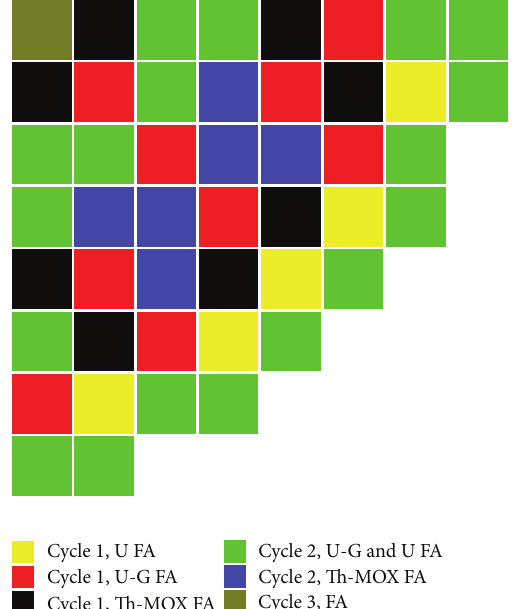
Figure 4: The figure shows the lower right corner of the Th-MOX core loading